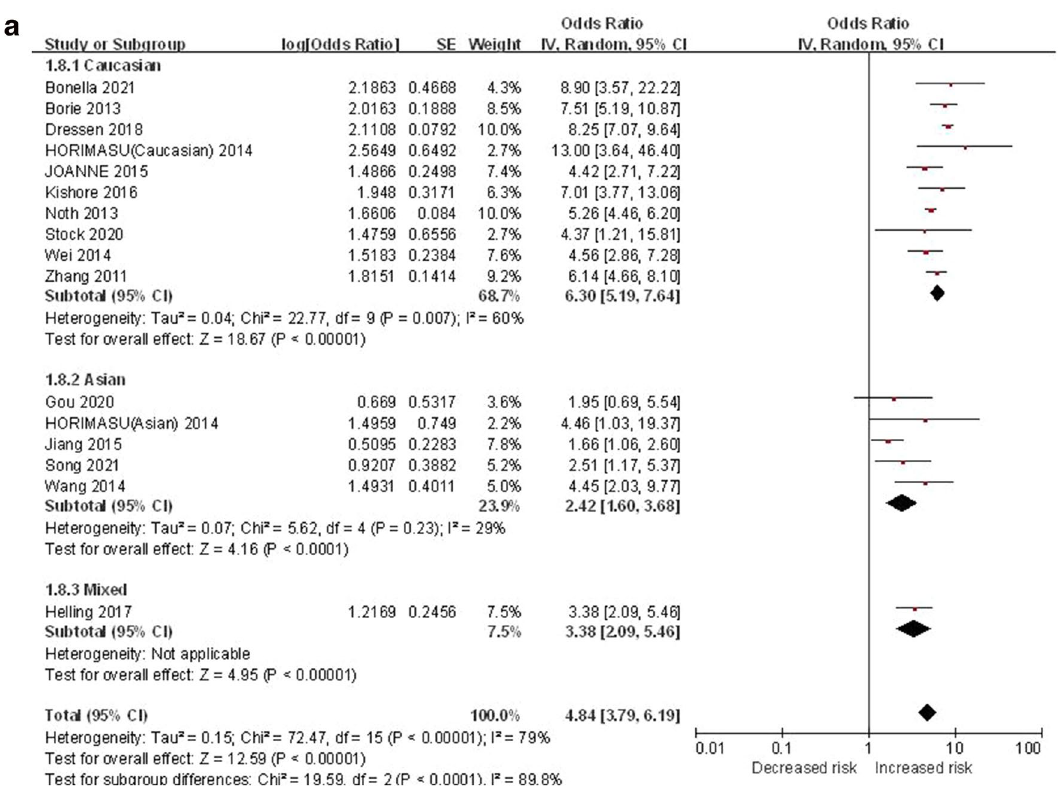
Figure 5. The GT + TT vs. GG model was used to evaluate the correlation between MUC5B gene polymorphism and IPF susceptibility. ( a ) Forest plot of GT + TT vs. GG genetic model. ( b ) Trial sequential analysis of MUC5B polymorphism and IPF risk using the dominant genetic model (GT + TT vs. GG) (Adjusted Boundaries Print). Although the combined sample size (N = 13,162) did not exceed RIS (N = 49,050), the cumulative Z curve crossed the conventional boundary and the TSA boundary, and the association was established in advance. ( c ) Inverted funnel chart of GT + TT vs.